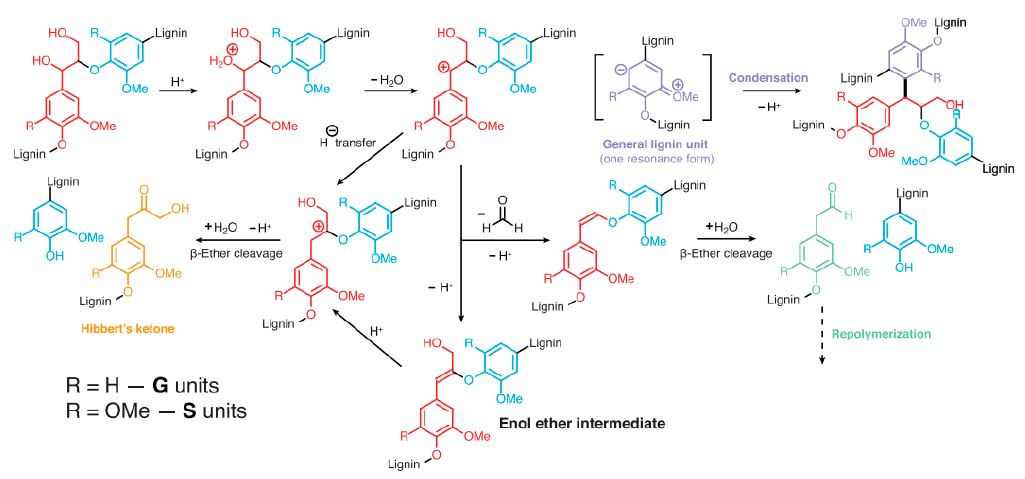
Figure 3. Lignin acidolysis and condensation routes [20].